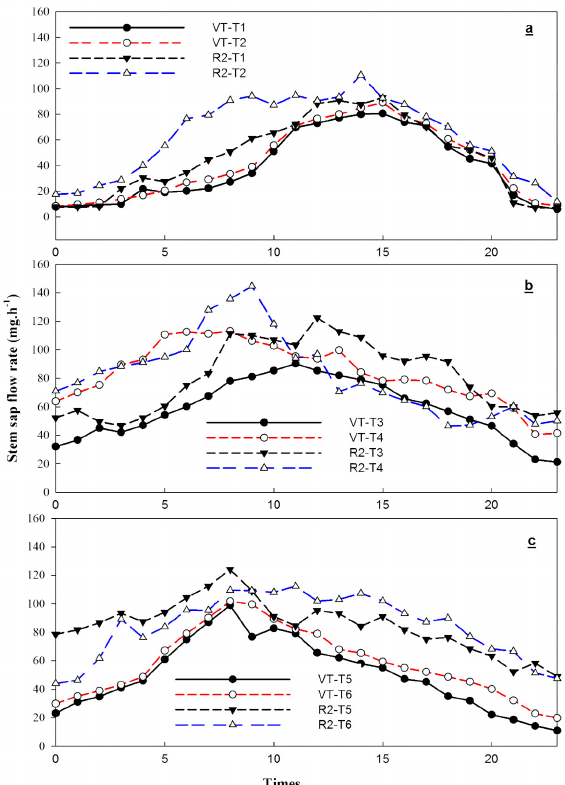
Figure 6. Daily changes in stem sap flow velocity at reproductive period under organic manure in three different planting densities. In this figure, letter ( a ) means the year 2011, ( b ) means the year 2012 and ( c ) means the year